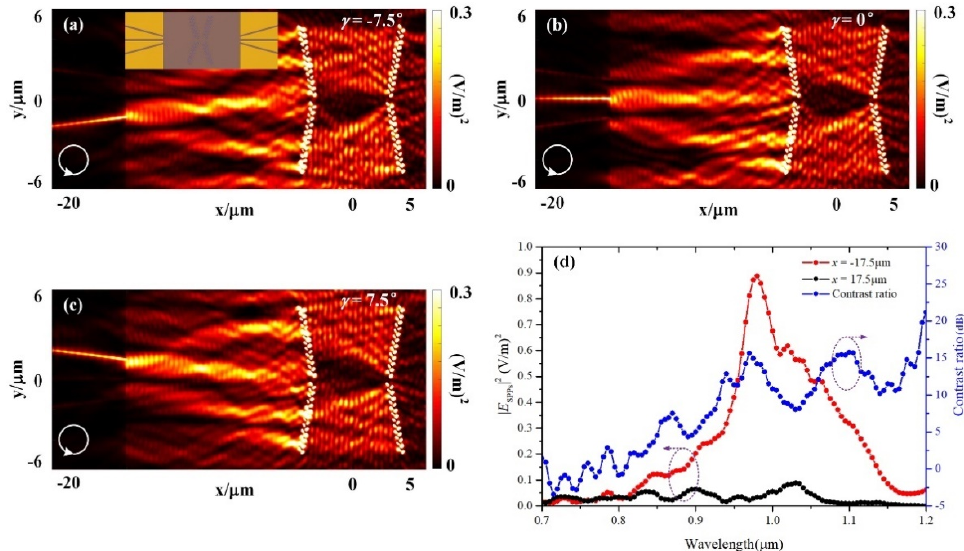
Figure 10. ( a – c ) The coupling effect of a single nondiffracting SPP beam to different PMMA SPP waveguides when the inclined incidence angle is − 7.5°, 0°, and 7.5°, respectively. The inset in ( a ) is the structure scheme of the spin router. ( d ) The relationship between the incident wavelength and the SPP intensity at points ( − 17.5 µm, 0.09 µm) and (17.5 µm, 0.09 µm), in addition to their contrast ratio under LCP incident light.